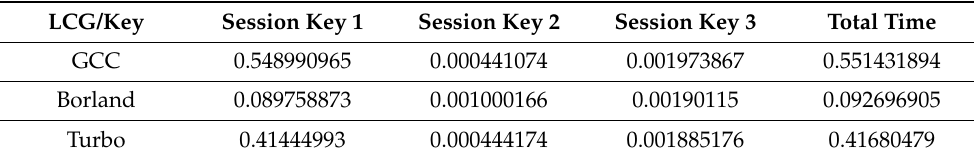
Table 4. LCG-based IoT device 1 to IoT device 2 authentication time (s).